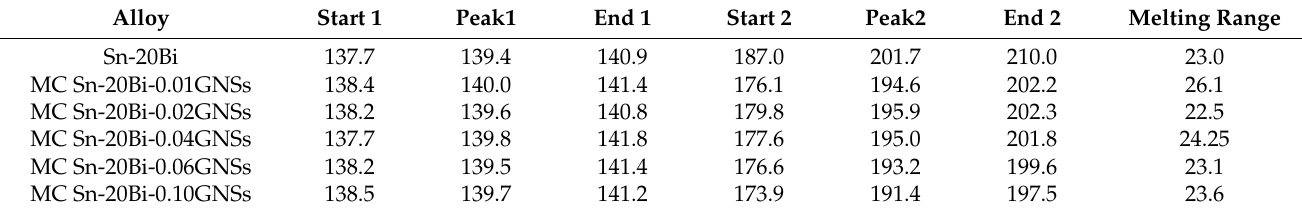
Table 1. DSC analysis results of MC Sn-20Bi- q GNSs alloys (Temperature: ◦